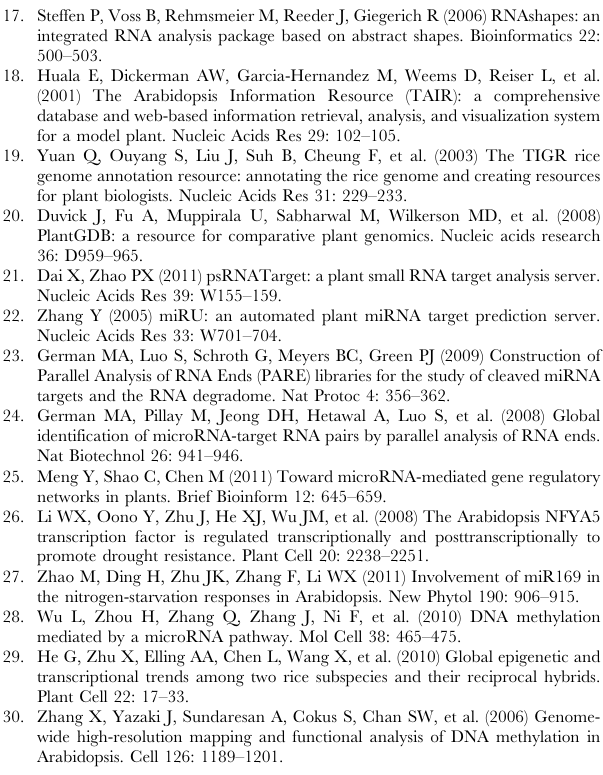
Table S2 Plant degradome sequencing data sets used in this study. (PDF) Table S3 Sequence information of identified mature RC-miRNAs, RC-miRNA*s, and RC-miRNA precursors. (XLS) Table S4 List of mature RC-miRNAs used for cleavage target identification and DNA methylation analysis in Arabidopsis and rice, and the mature RC-miRNAs with normalized total read counts more than 20 RPM (reads per million) in other plant species (the mature RC- miRNAs of soybean with accumulation levels higher than 20 RPM were also used for degradome sequencing data-based target identification). (XLS) Table S5 List of identified RC-miRNA–cleavage target regulatory relationships in Arabidopsis and rice. (XLS) Table S6 RC-miRNA-guided DNA methylation and their target genes in Arabidopsis and rice. (XLS) Table S7 Comparison of the accumulation levels be- tween RC-microRNAs and the corresponding micro- RNAs in the sixteen plant species (only the RC-miRNAs with accumulation levels higher than 20 RPM were included). (PDF) Data S1 Randomly selected 1000 sequences antisense to the protein-coding genes in Arabidopsis . (TXT)